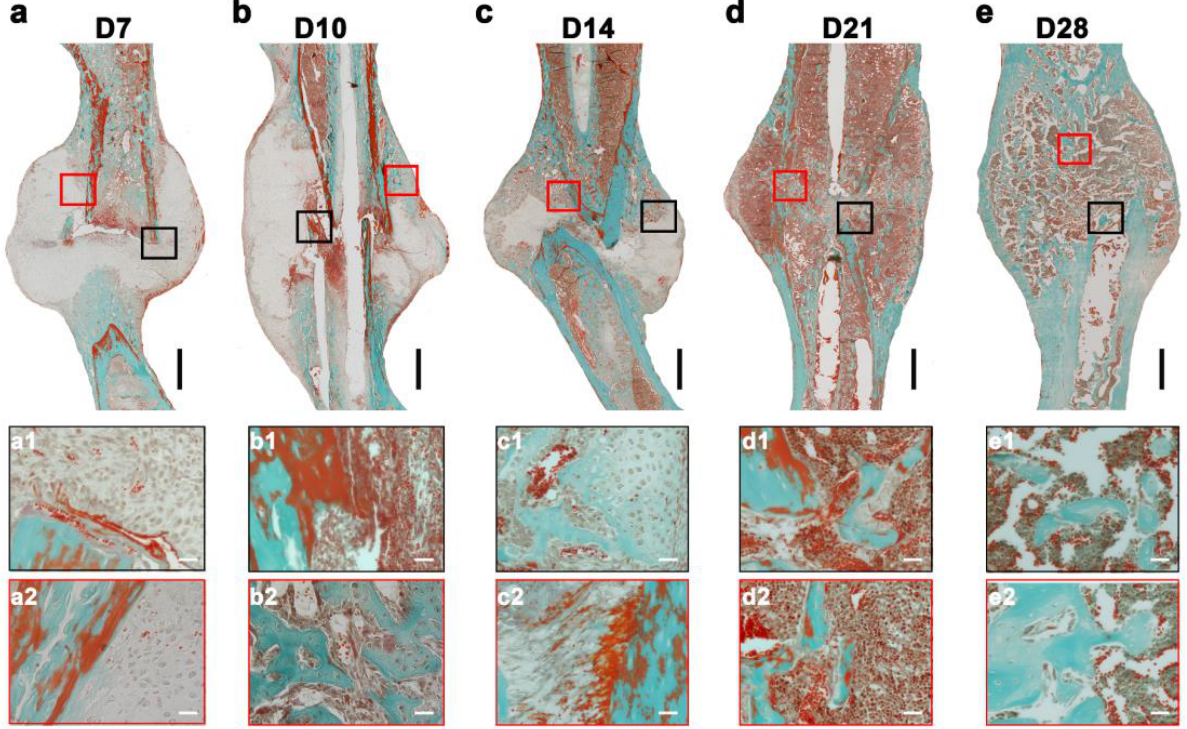
Figure 1. Assessment of bone matrix mineralization at the fracture site reflects the healing pattern. Trichrome Masson Goldner staining of the fractured callus differentiated mineralized (green) and nonmineralized (red) portions of intramembranous bone (red rectangle) and endogenous bone formation (black rectangle). ( a , ( a1 , a2 )) A higher portion of the nonmineralized matrix was seen in the fractured callus at D7. ( b , ( b1 , b2 )) The patches of the mineralized matrix were seen in the periosteal regions within the callus at D10. ( c , ( c1 , c2 )) A lower number of chondrocytes and a larger area of the mineralized matrix were seen at D14 compared with earlier time points. ( d , ( d1 , d2 )) The advancement in bone matrix mineralization was evident by D21. ( e , ( e1 , e2 )) Bony bridging and complete mineralization of newly formed bone were seen by D28. (Green: mineralized bone, red: nonmineralized bone; scale bar: upper panel (250 µ m), lower panel (25 µ m)). Analysis of vascularization around callus was carried out using Alpha smooth muscle actin (ASMA) IHC (Figure 2a). Histomorphometry showed the largest ASMA positive area at D7, and the lowest at D21. ASMA positive area varied at D10, D14, and D28 with no statistically significant differences. Matrix extracellular phosphoglyco- protein (MEPE) and extracellular signal-regulated kinase (ERK) are important for ECM regulation. Descriptively, MEPE positive signal located in the fracture gap and periosteal region and around bone marrow fat cells at D7. At D10, MEPE signal was seen in prolif- erative chondrocytes and within bone marrow and later at D14 was seen within bone marrow and bone matrix (Figure 2b). ERK positive signal was seen around the callus border, in chondrocytes and within monocytes at D7; near proliferative chondrocytes and within bone marrow at D10 and in small patches in hypertrophy chondrocytes and bone marrow at D14. Later at D21 and D28, ERK signal was located within bone matrix and around fat cells present within bone marrow at D21 (Figure 2c). Glutathione Peroxi- dase 1 ( GPX1 ) is a mitochondrial gene which acts against oxidative stress to maintain bone homeostasis. GPX1 positive signal was seen in small patches within bone marrow and fracture callus at D7. At D14, the signal was located in proliferative chondrocytes, bone marrow, and bone lining cells. An increasing signal from D14 to D28 within bone marrow and bone matrix around fat cells was seen (Figure 2d). Descriptively in toluidine blue counter-stained sections, Ubiquitin B (UBB) signal was seen in chondrocytes,